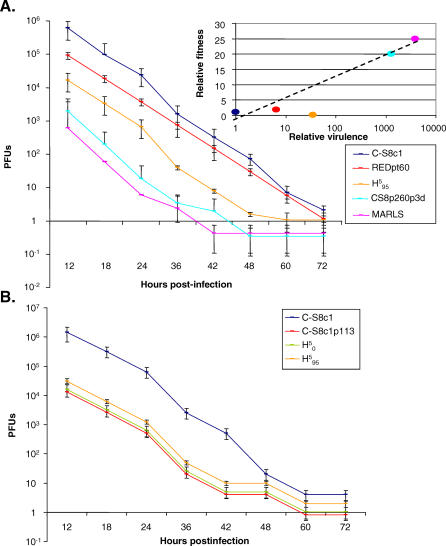
Killing of BHK-21 Cells by FMDVs(A) Time needed by C-S8c1, REDpt60,
, C-S8p260p3d, and MARLS to kill 104 BHK-21 cells as a function of the initial number of infectious units (PFU) added. The virulence assay is described in Materials and Methods. Each value represents the mean and standard deviation from triplicate assays. Inset: Relative fitness as a function of relative virulence values of FMDVs. The regression (discontinuous) line defined by C-S8c1, REDpt60, C-S8p260p3d, and MARLS is y = 3.026Ln(x) – 1.1028; R
2 = 0.9721.
The regression line including
is y = 3.1458Ln(x) – 3.5111; R
2 = 0.8507 (not drawn).
(B) Time needed by C-S8c1, C-S8c1p113,
, and
to kill 104 BHK-21 cells as a function of the initial number of PFU. Each value represents the mean and standard deviation from triplicate assays. The viruses analyzed are described in Materials and Methods, and their evolutionary relationship is depicted in Figure 1. Virulence values are given in Tables 1, 2, and S1.